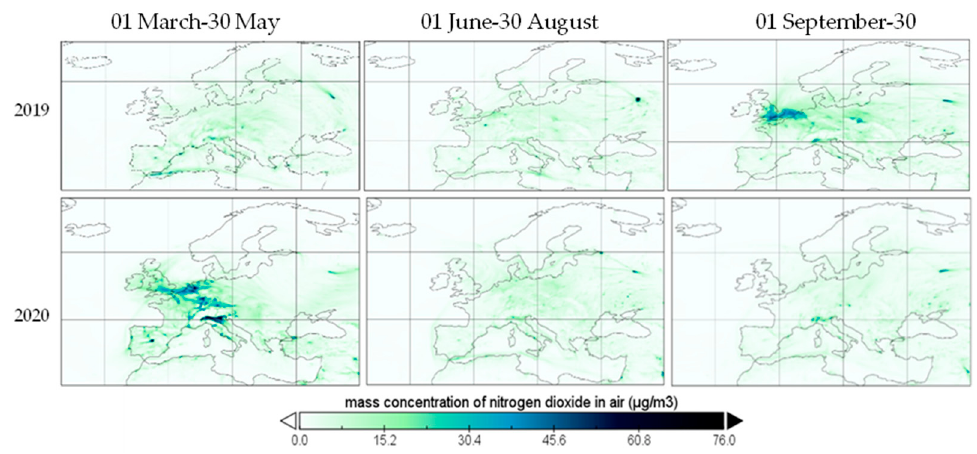
Figure 11. Nitrogen dioxide over Europe during restriction period, 2019 and 2020.